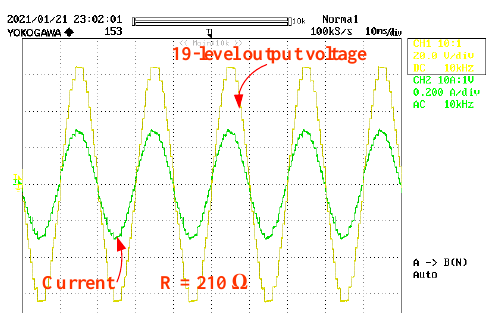
Figure 9. 19-level output waveform.